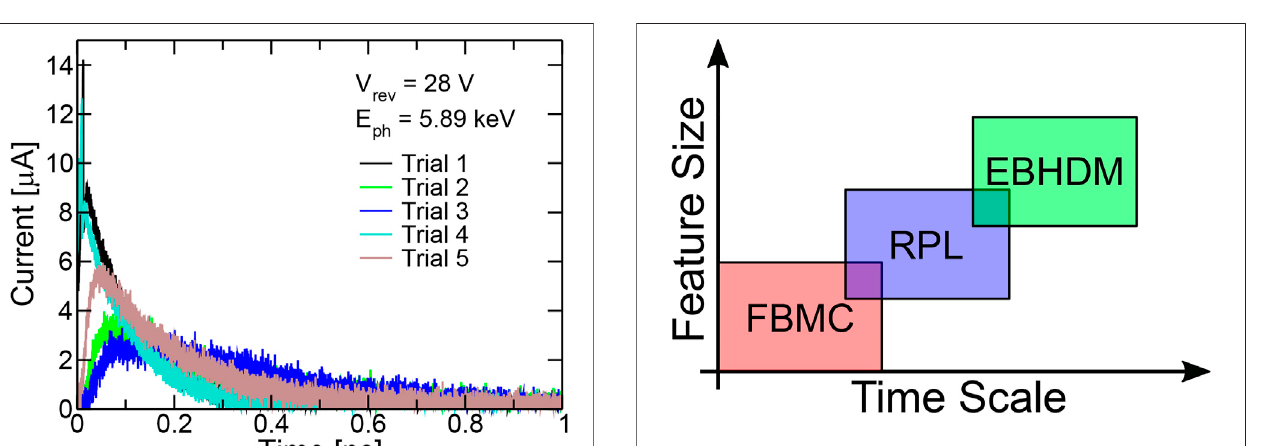
FIGURE 14 | Schematic representation of different simulation approaches for II in APDs. Each model is suited to analyze different feature sizes and time